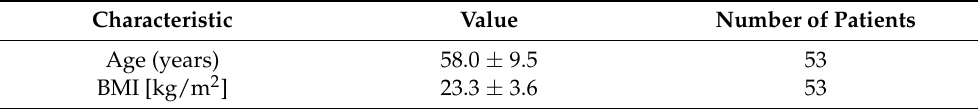
Table 2. Demographic and clinicopathological characteristics for the enrolled benign ovarian cystic lesion